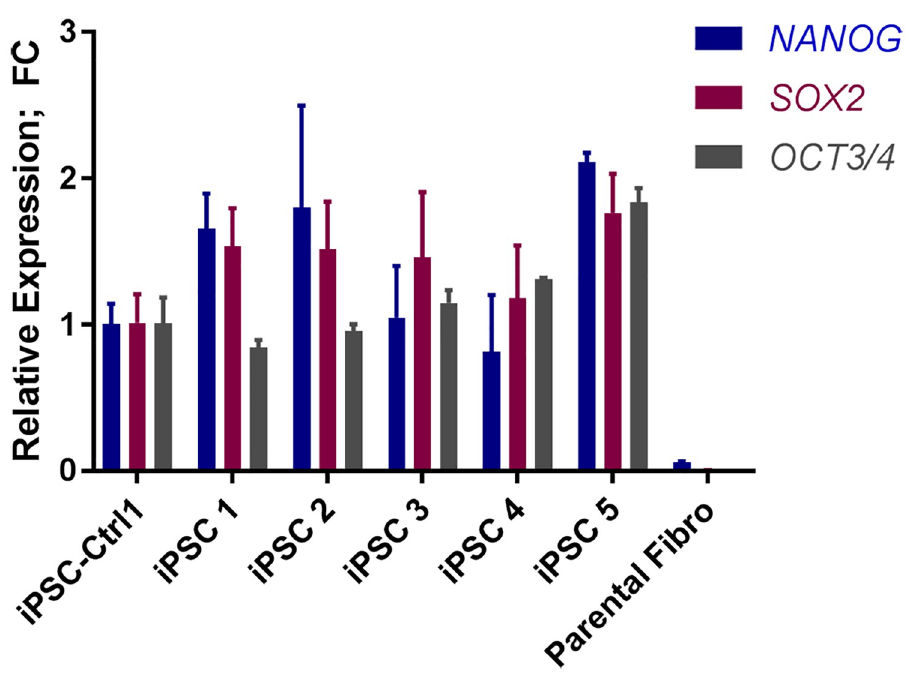
Fig 4. Expression profile of centenarian-derived iPSC clones for pluripotency genes OCT4, SOX2, NANOG. Expression was normalized to iPSC-Ctrl1. Parental fibroblasts were used as a negative control.